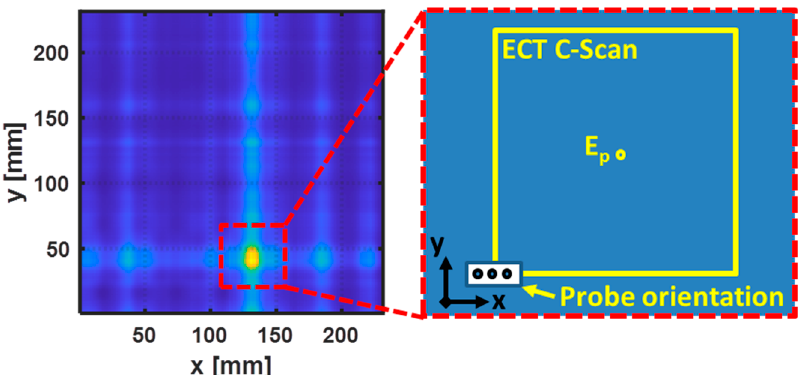
Figure 12. Representation of the C-scan performed in the vicinity of the estimated position of the fiber break.